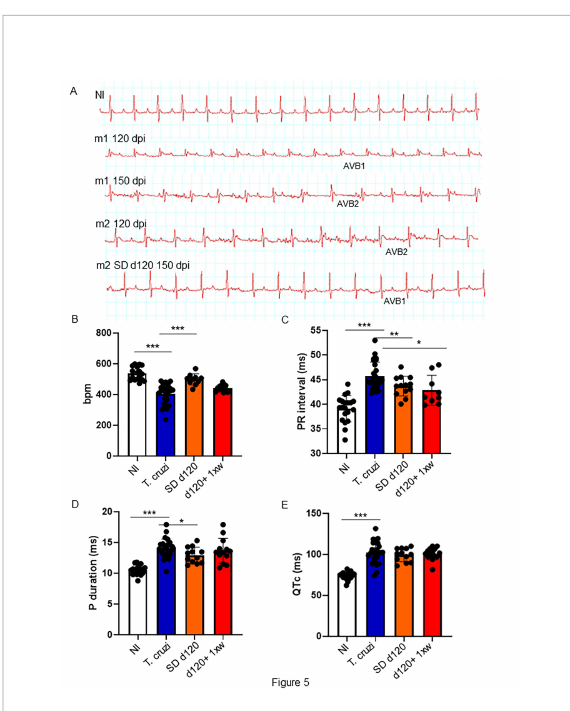
FIGURE 5 1D11 reverses ECG abnormalities in a mouse model of chronic Chagas ’ heart disease. Representative electrocardiographic tracings of each group at 150 dpi are shown (A) . 1D11 SD d120 treatment resulted in best heart rate, in beats per minute (bpm) (B) ; PR interval in milliseconds (C) ; P duration in milliseconds (D) and QTc interval in milliseconds (E) . Signi fi cant differences between non infected and infected mice treated or not with 1D11 are indicated by *p< 0.05, **p< 0.01, ***p<